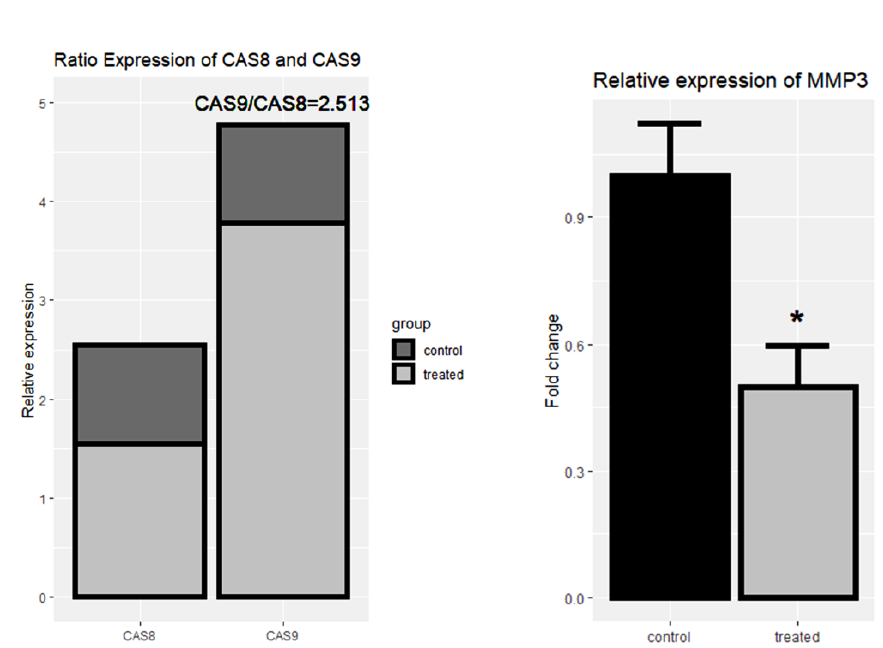
Figure 5. The rational mRNA expression of Casp-8 and Casp-9 after the treatment with 17.7 µ g / mL rCTII in the SK-MEL-3 cell line ( A ). The relative expression of matrix metallopeptidase 3 (MMP-3) after the treatment with rCTII ( B ). The expression of candidate genes was evaluated through real-time PCR in the control and treated group. Our result illustrated that this protein potentially activated the intrinsic pathway of apoptosis more than extrinsic pathways. In addition, there was a significant down-regulation in the expression level of MMP-3 in treated cancerous cells. Error bars display the ± SD. The independent t -tests assessed the p -values. p < 0.05